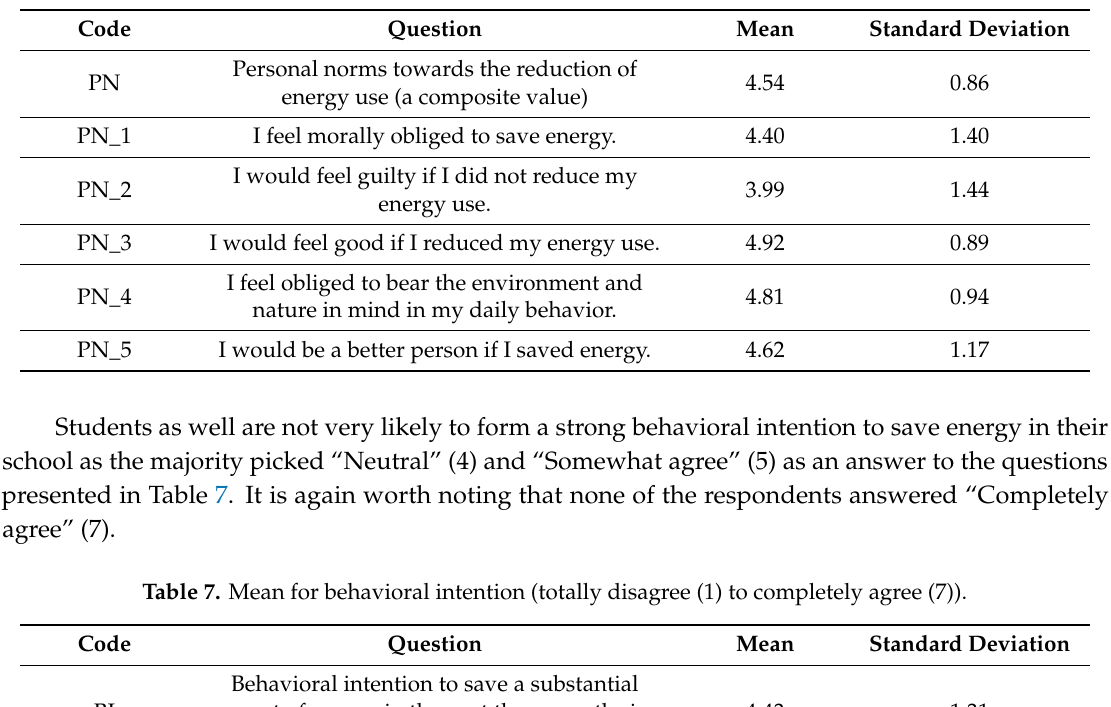
Table 6. Mean for personal norms (totally disagree (1) to completely agree (7)).